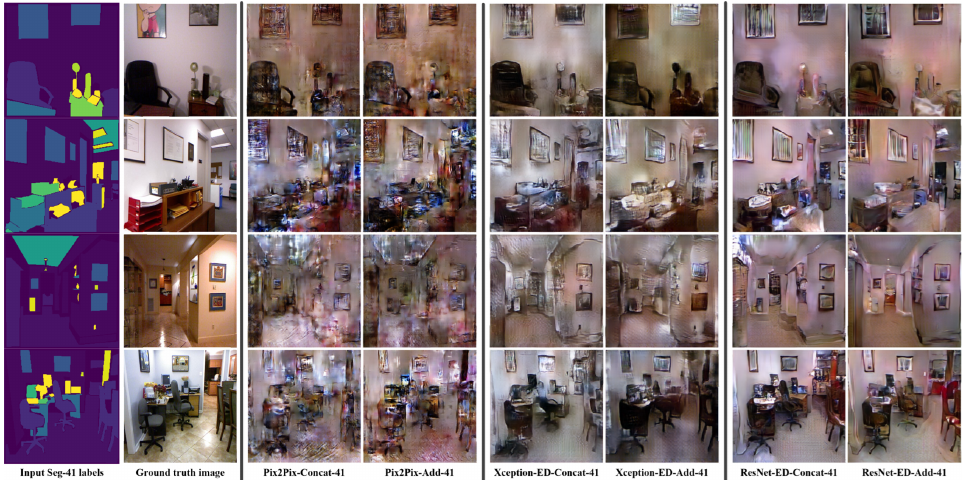
Figure 4. Sample results were obtained by Pix2Pix, Xception-ED, and ResNet-ED with concatenation and addition as feature merging of the encoder and decoder features, while training with 41 semantic labels on the NYU depthV2